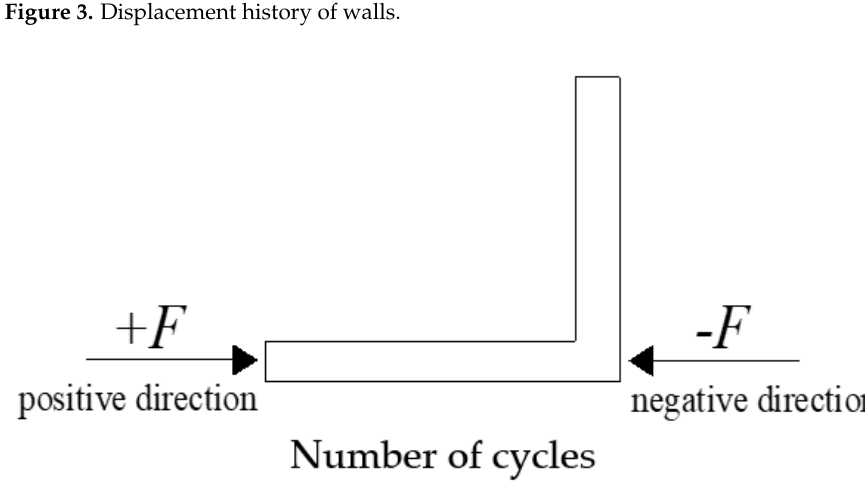
Figure 4. Loading directions.